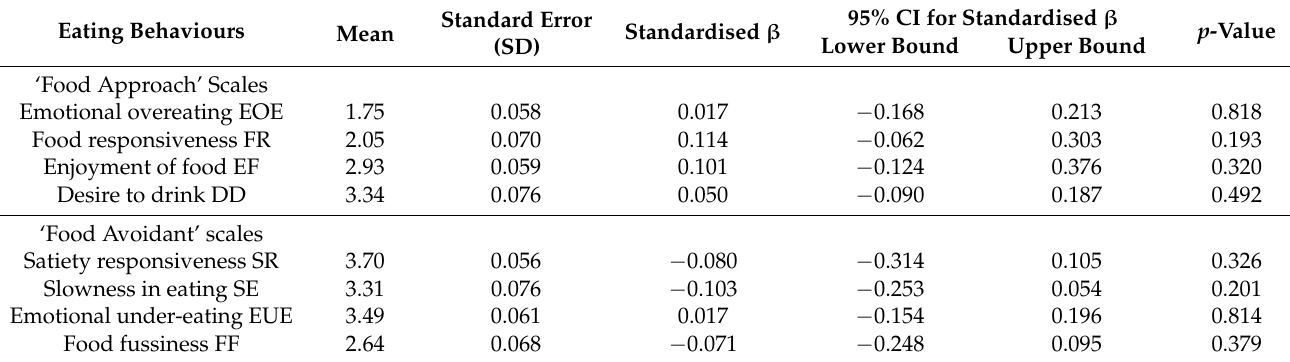
Table 7. Hierarchical linear regression analyses for BMI z-scores on CEBQ